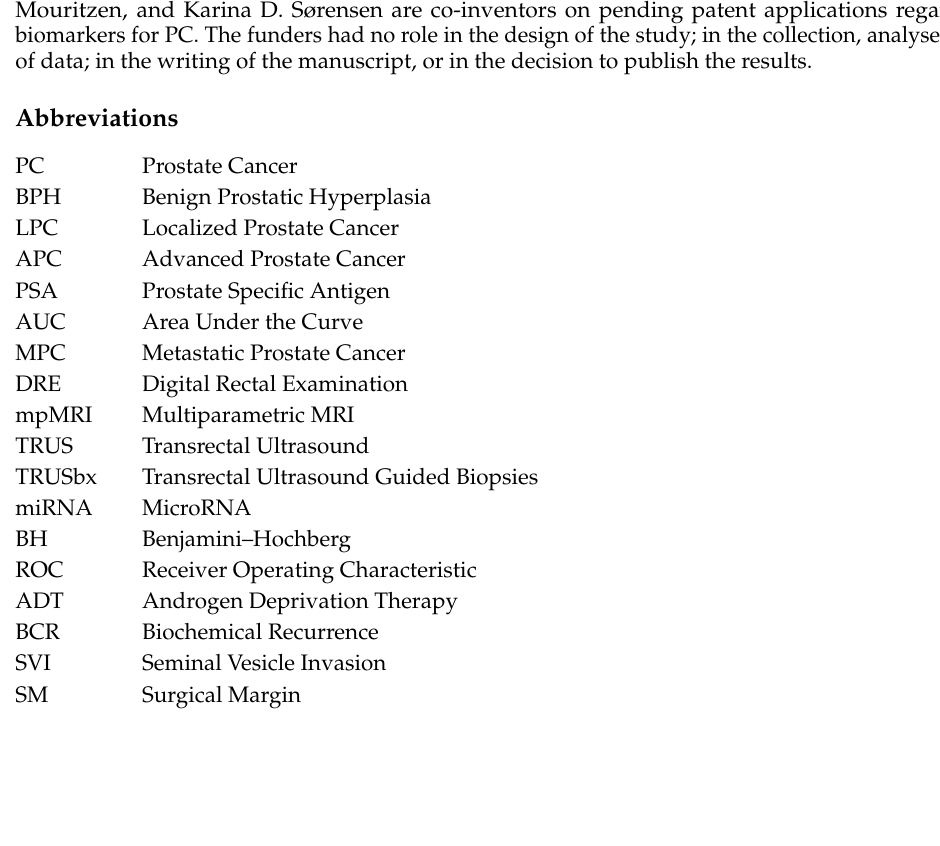
Table S1. Coe ffi cients for the logistic regression model for combining bCaP + PSA, or bCaP + PSA + DRE + Age. PSA: prostate specific antigen; DRE: digital rectal examination. Table S2. Dysregulated miRNAs between samples from BPH patients and samples from APC patients. Bold, underlined miRNAs overlap with miRNAs in Supplementary Table S2. BPH: benign prostatic hyperplasia; LPC: localized prostate cancer; APC: advanced prostate cancer. Table S3. Dysregulated miRNAs between samples from LPC patients and samples from APC patients. Bold, underlined miRNAs overlap with miRNAs in Supplementary Table S1. BPH: benign prostatic hyperplasia; LPC: localized prostate cancer; APC: advanced prostate cancer. Table S4. Dysregulated miRNAs between samples from LPC patients with low PSA ( ≤ 10 ng / ml) versus high PSA ( > 10 ng / ml). LPC: localized prostate cancer; PSA: prostate specific antigen. Table S5. Dysregulated miRNAs between samples from TRUSbx patients with benign versus malignant